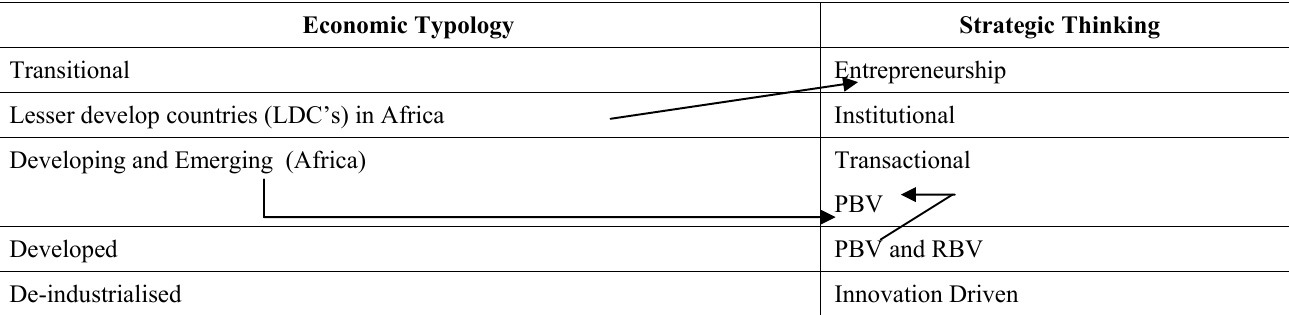
Figure 1: Relationship between economic typology and strategic thinking Transactional thinking stems from transaction